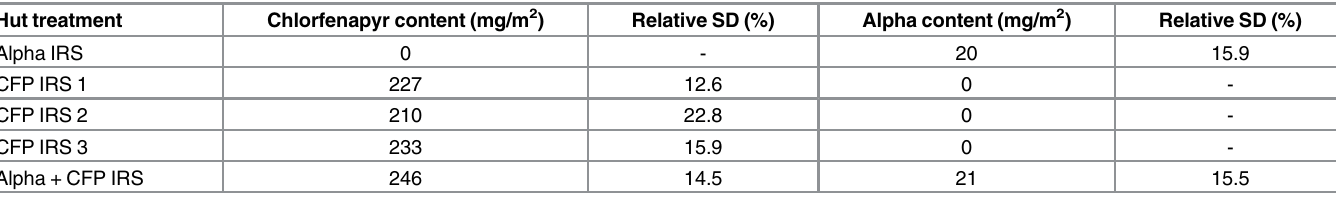
Table 5. Chemical analysis of filter papers from IRS-treated experimental huts in Cove, Benin. Mean insecticide content * . Hut